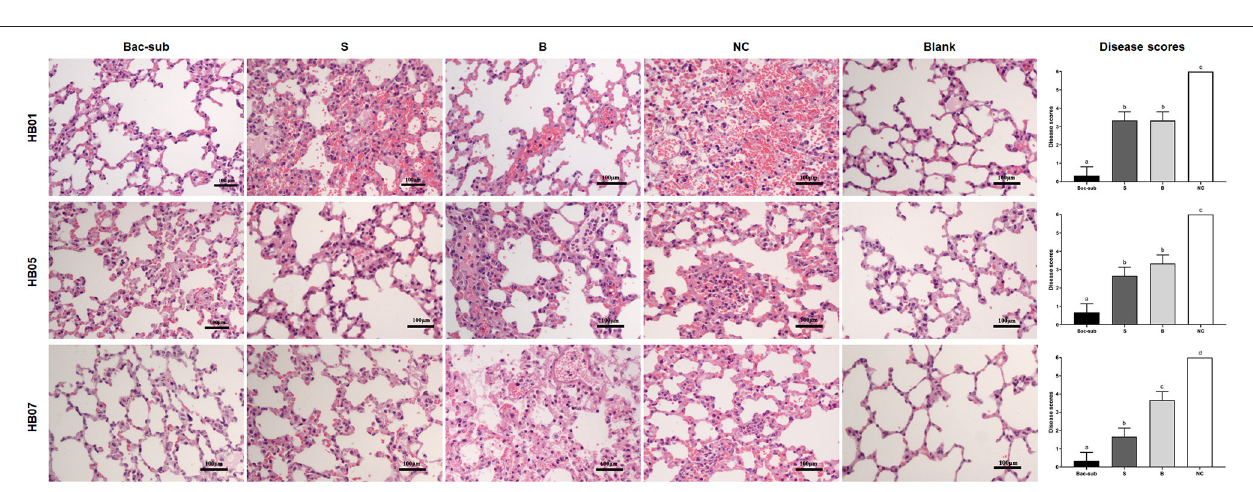
FIGURE 5 | Representative micrographs of lung tissues with hematoxylin and eosin staining and disease scores of lung injury. Mice were vaccinated two times with the Bac-sub vaccine, subunit vaccine (S), bacterin (B), and PBS (NC), and then challenged with A. pleuropneumoniae strain HB01, HB05, and HB07, respectively. Blank is the lung of normal mice. Original magnifications × 100. Different letters at the top of columns means significantly different disease scores ( p < 0.05), otherwise not significant ( p >